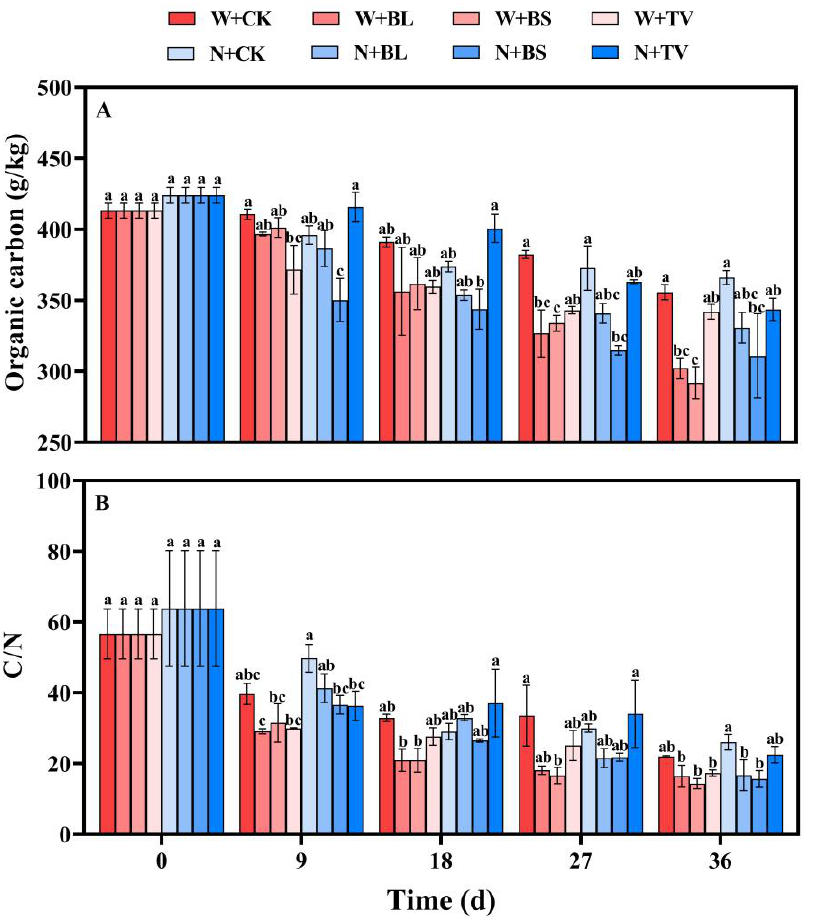
Figure 8. Changes in carbon and carbon–nitrogen in the treatments. Means ± SEs with different letters in each parameter indicate significant statistical differences ( p < 0.05). ( A ) Organic carbon; ( B ) C/N.